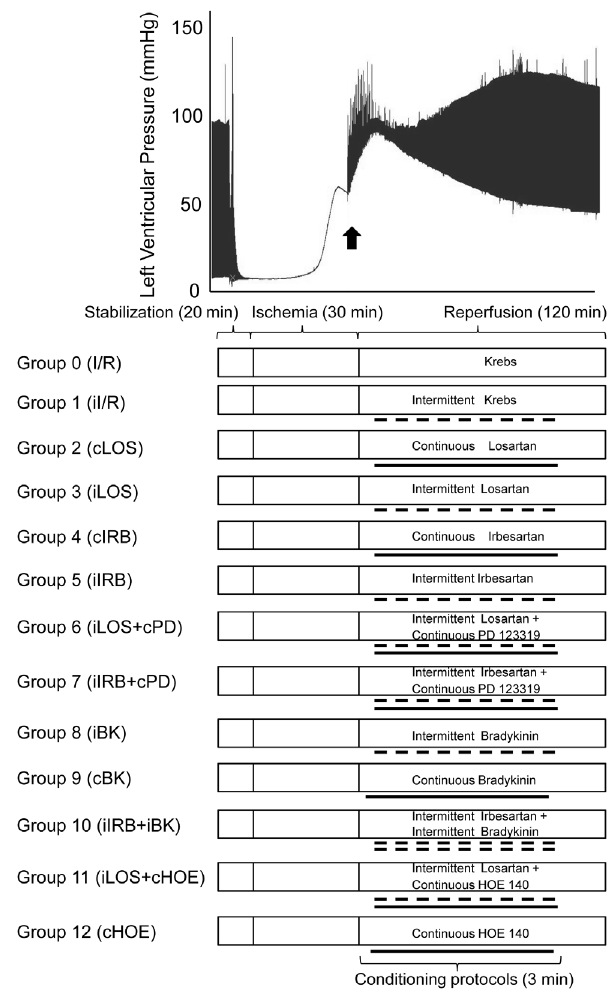
Figure 1. Experimental design. Each heart was isolated and mounted on a Langendorff system. Perfused hearts were stabilized for 20 min, and then subjected to global ischemia (30 min) followed by reperfusion (120 min). Intermittent post-conditioning algorithms during the initial 3 min of reperfusion alternated 9 cycles (10 sec) of drug infusion to 9 cycles of Krebs’ infusion according to protocols illustrated above.